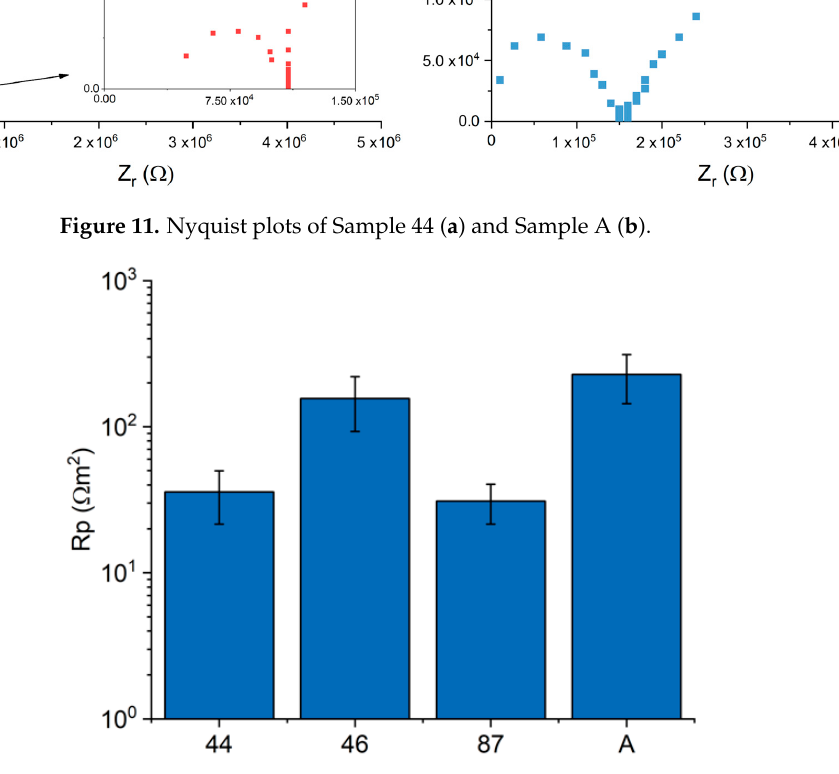
Figure 12. Polarization resistance measurements on iron fragments from the San Carlone of Arona.